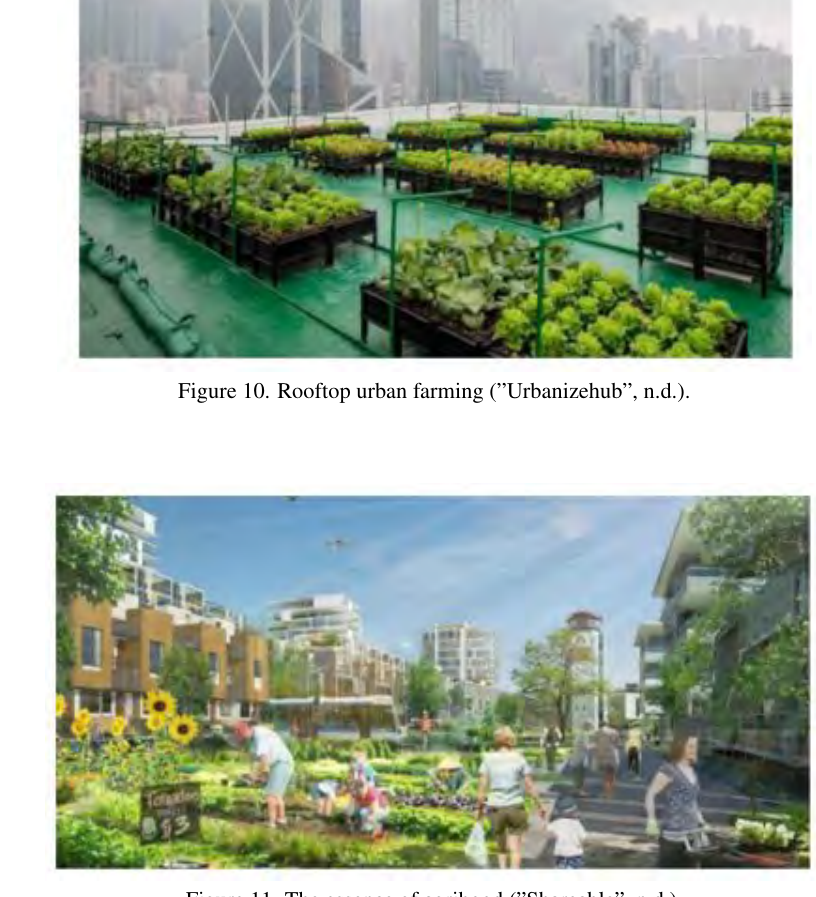
Figure 11. The essence of agrihood (”Shareable”, n.d.).